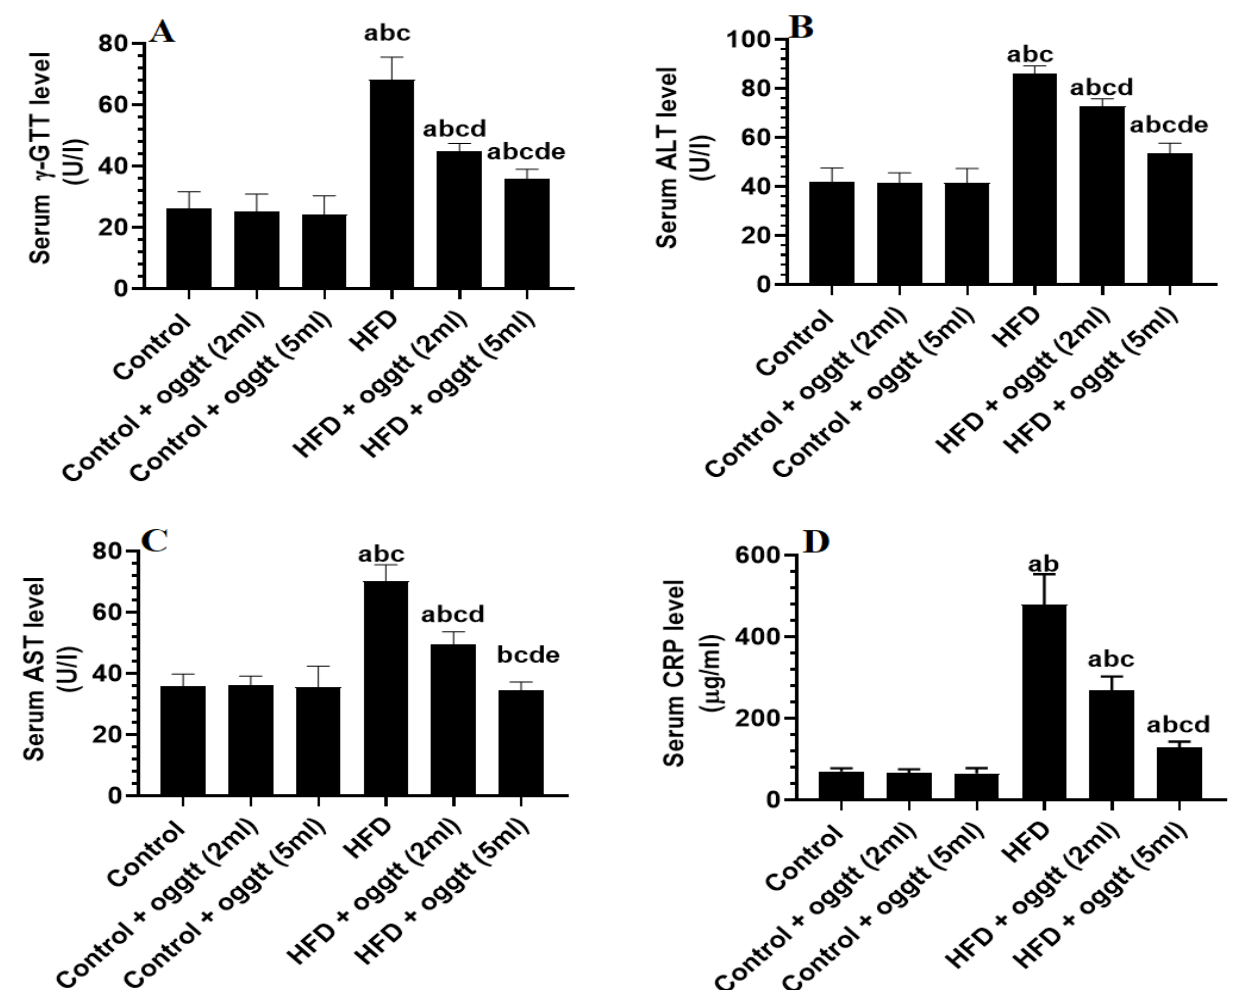
Figure 3. Oggtt milk prevents the increases in levels of gamma-glutamyl transpeptidase (GGT) ( A ), alanine aminotransferase ( B ), aspartate aminotransferase (AST) ( C ), and C-reactive protein ( D ) in the serum of high-fat diet (HFD)-fed-rats in a dose-dependent manner. Data were expressed as means ± SD for n = 10 rats/group. a, vs. control; b, vs. control + oggtt (2 mL); c, vs. control + oggtt (5 mL); d, vs. HFD; and e, vs. HFD + oggt (2 mL).